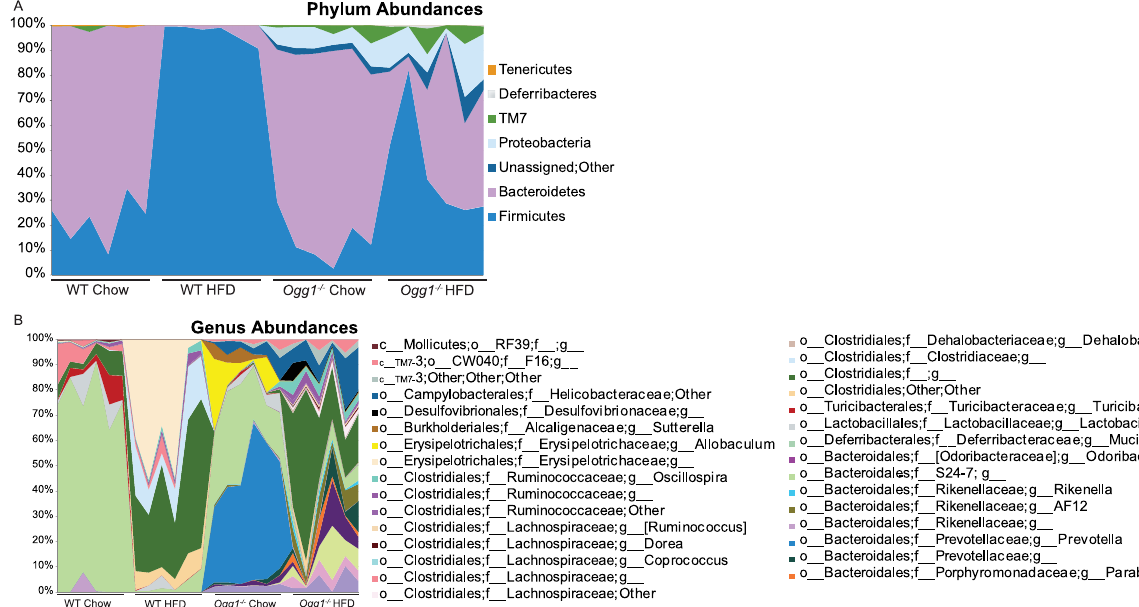
Fig 2. Diversity area graphs. Data show diversity of the gut microbiota recovered from chow and HFD-fed WT and Ogg1 -/- mice at the (A) phylum and (B) genus levels. Results are from the analysis of microbial sequences recovered from the fecal samples as described in Methods. Taxonomy was assigned in MACQIIME using the Greengenes taxonomy and a Greengenes reference database (currently version 12_10) [45], following the default taxonomy assignment method with the RDP Classifier 2.2 [46].